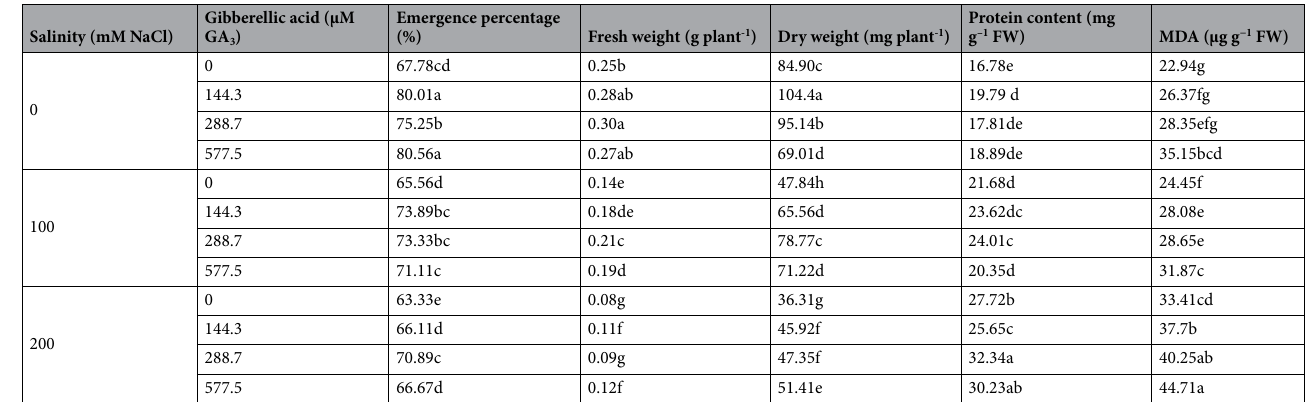
Table 2. Impacts of interaction between different salinity levels and different gibberellic acid levels on emergence percentage, fresh weight, dry weight, protein content and MDA content on sorghum seedlings. Within the same column, means followed by the different letters are statistically different at P ≤ 0.05.